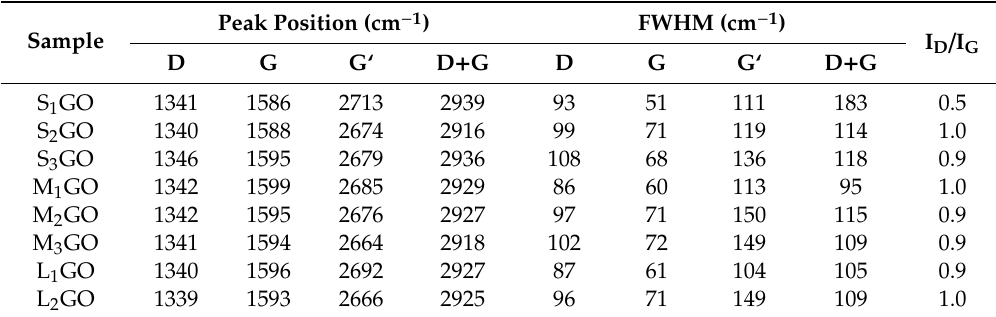
Figure 5. Collection of normalized Raman spectra of the examined graphene oxide powders before the cross-linking process, labeled according to the Table 1 parameters. Table 2. Raman spectra analysis of the graphene oxide powders before the cross-linking process, labeled according to the Table 1